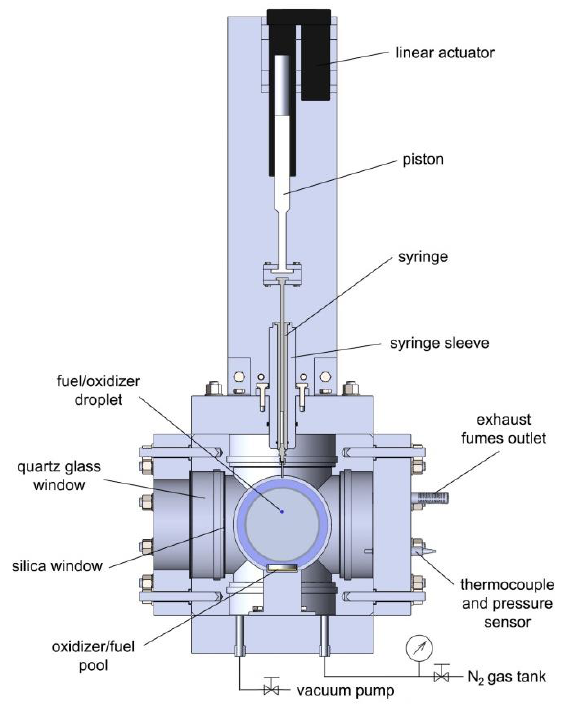
Fig. 6. Schematic diagram of the drop test